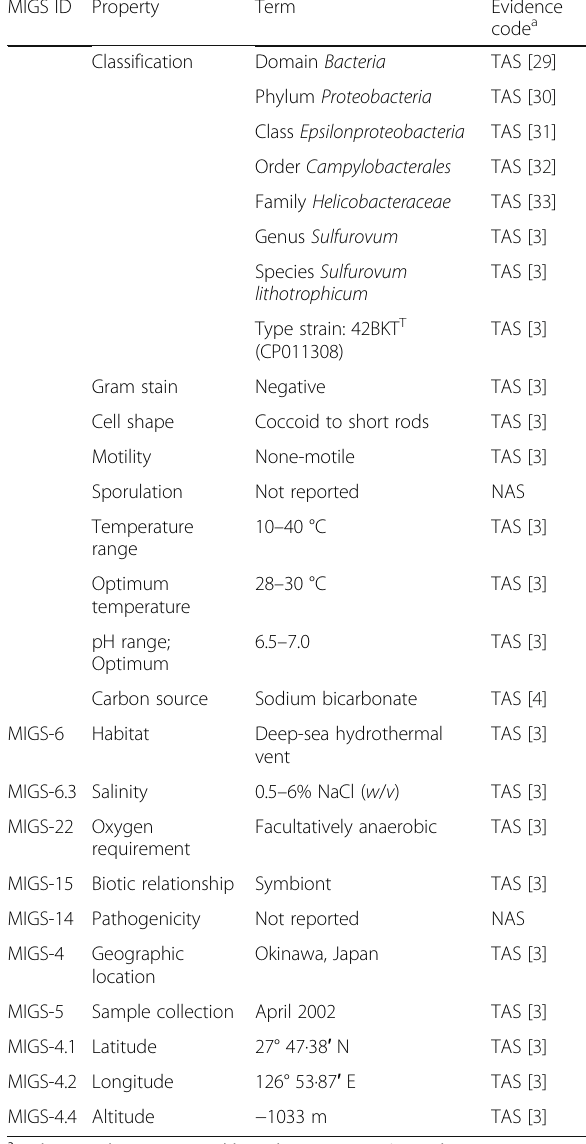
lithotrophicum strain 42BKT T